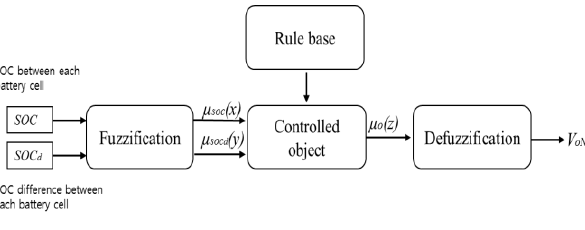
Figure 7. Definition of the membership function.